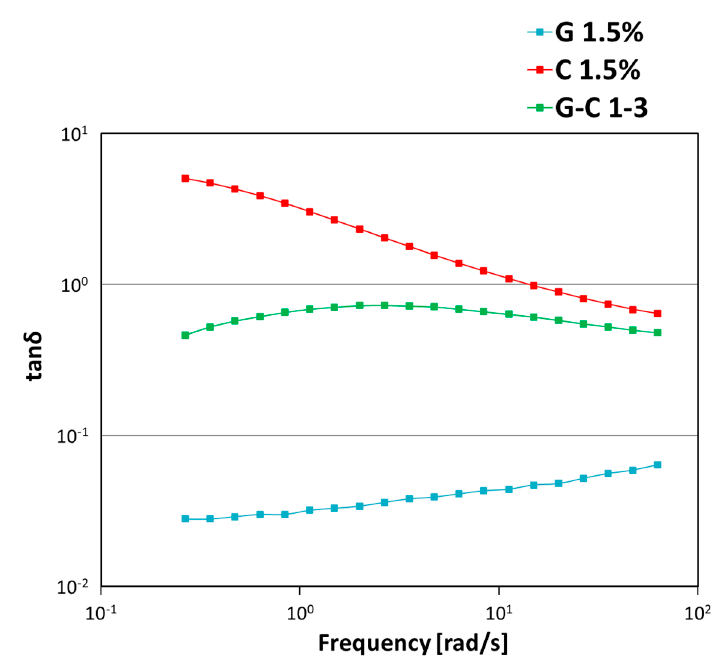
Figure 3. Damping factor tan δ trends as a function of the frequency for the samples prepared with G, C, and the G–C association (ratio 1:3) at 1.5% w/w of the total polysaccharide amount. The values of G ′ and G ″ (taken at a frequency of 1 Hz) of the G–C associations used at a ratio of 1:3 and increasing polymer concentrations are reported in Figure 4. Lower concentrations (0.75%) produced the formation of liquid-like systems with a higher loss modulus (G ″ ). Higher concentrations were needed to have gel-like systems with greater elastic properties. Over 1% of the total polymer amount, G ′ dominated over G ″ , and both moduli increased by increasing the polymer concentrations.